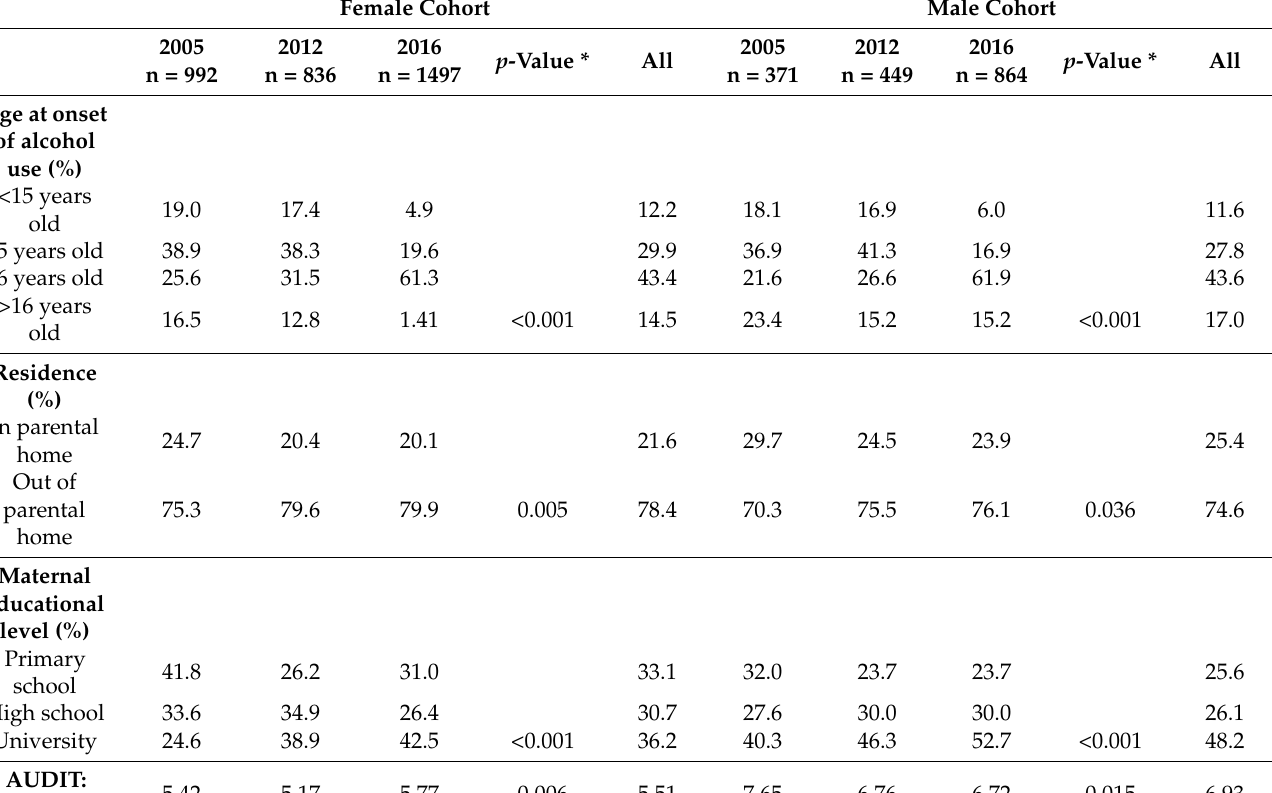
Table 1. Sociodemographic characteristics and AUDIT test scores of 2005, 2012 and 2016 freshman cohorts by gender